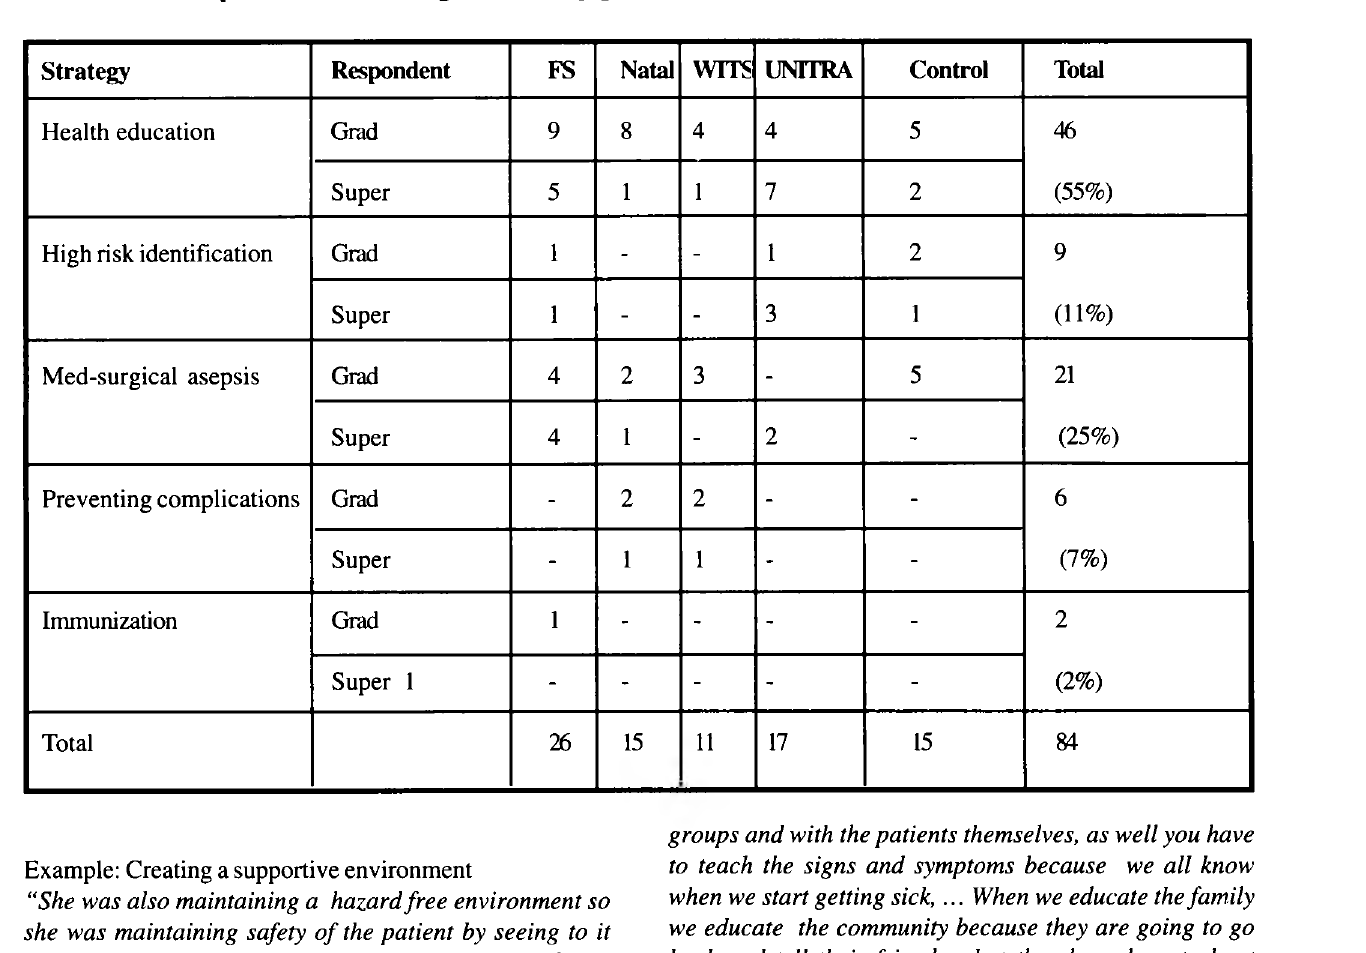
Table 2: Illness prevention strategies used by